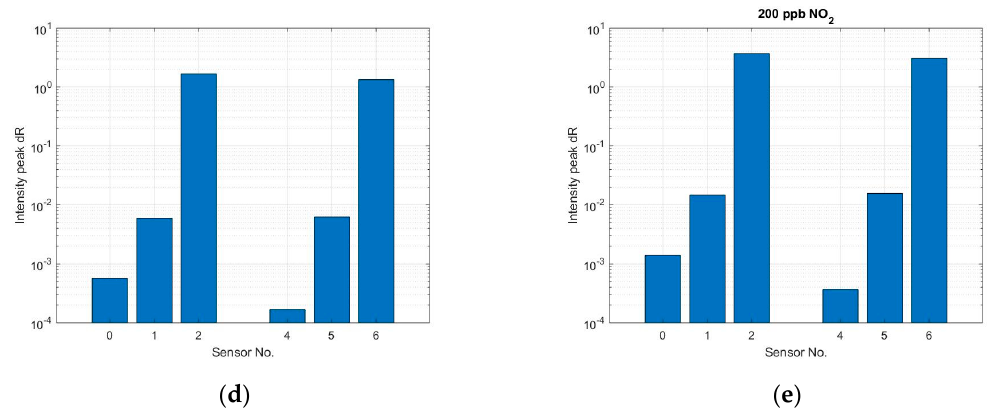
Figure 8. ( a ) The blue curve shows the response of sensor S 0 after exposure to 100 ppb of nitrogen dioxide, the red curve shows the derivative of the same sensor. The temperature of the sensor during the measurement was 250 °C and the relative humidity inside the test cell was 20%. ( b , c ) Physisorption time of sensors S 0 , S 1 , S 2 , S 4 , S 5, and S 6 when exposed to 100 and 200 ppb NO 2 , calculated using the first derivative. ( d , e ) Peak intensity of the first derivative of the sensor´s signal during the physisorption. This value was used to compare the response speed of the different sensors.